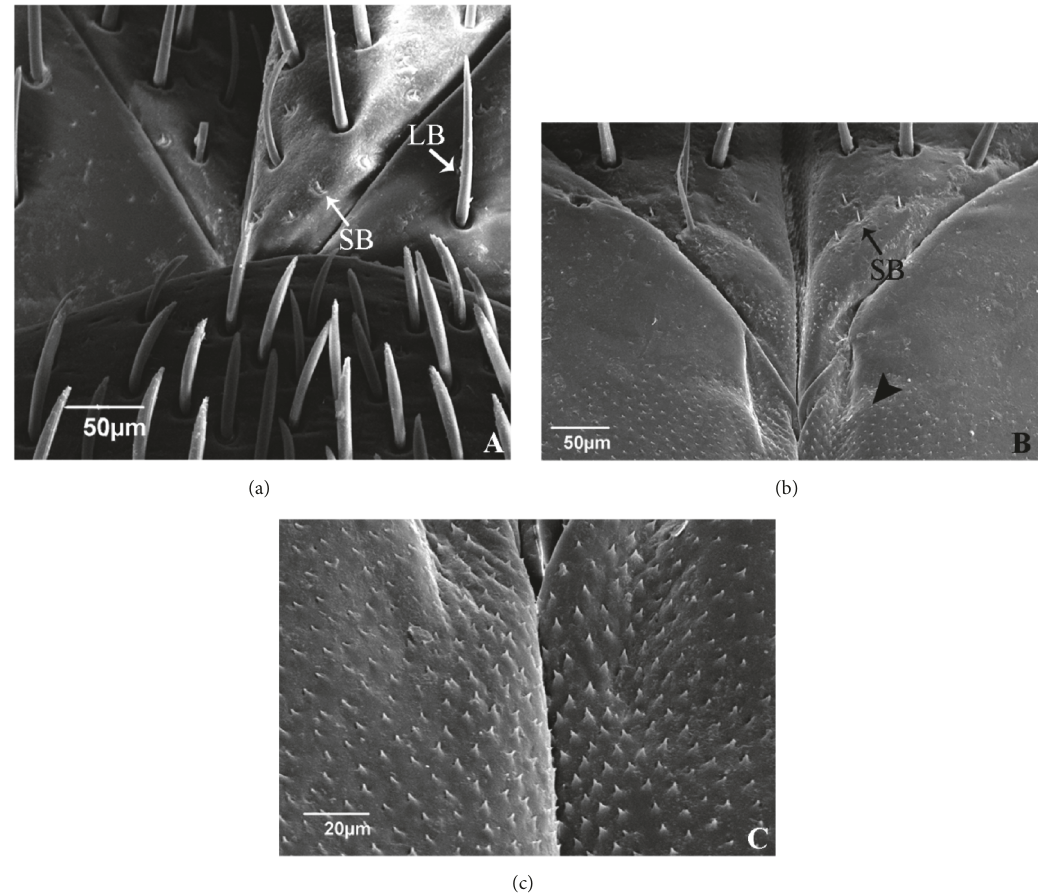
Figure 6: (a) VIII gonapophyses of the Triatoma carcavalloi with short bristles (SB) and long bristles (LB) . (b) Short bristles (SB) and cuticular structures similar to spines (arrowhead) in VIII gonapophyses of the Triatoma circummaculata . (c) Cuticular structures similar to spines (arrowhead) in VIII gonapophyses of the Triatoma rubrovaria